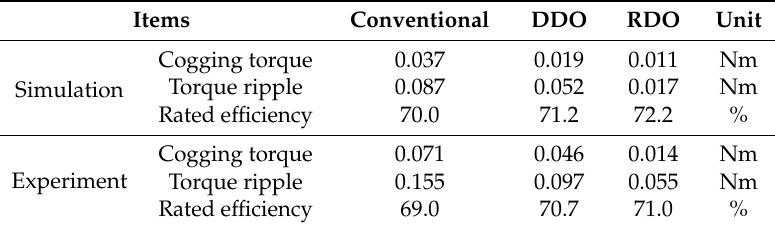
Table 5. Simulation and experimental